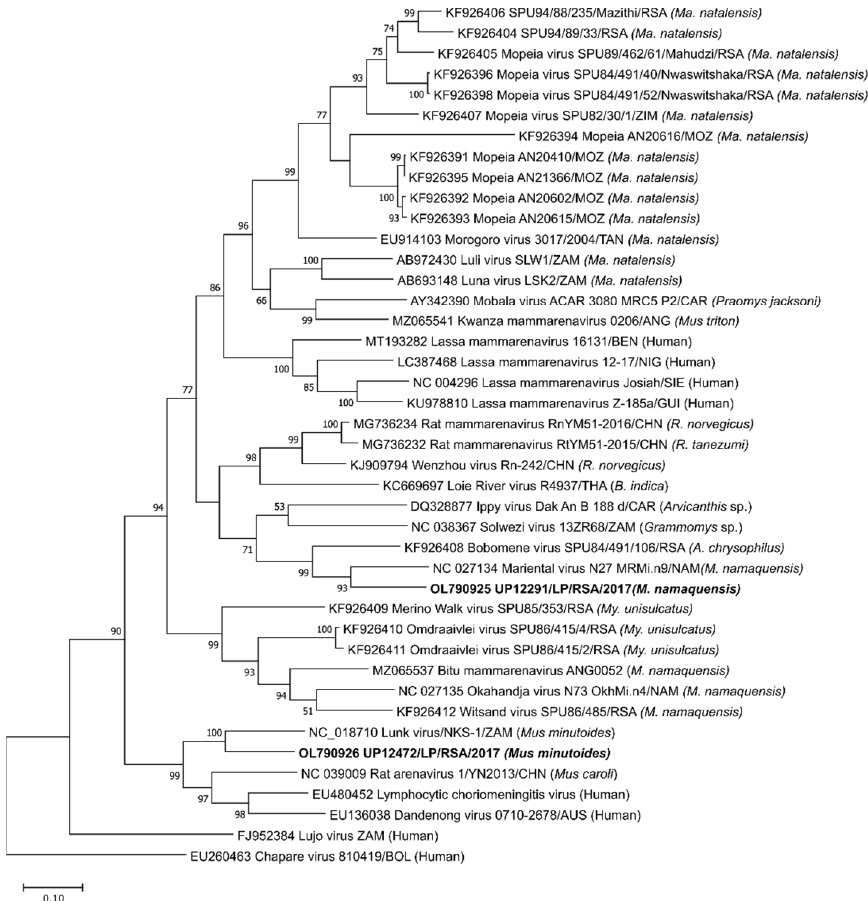
Figure 3. Phylogeny of a 912-nucleotide region of the S segment nucleoprotein gene constructed by maximum likelihood approach using the Jukes-Cantor substitution model in MegaX with 1000 bootstrap replicates. Sequences in bold denote those reported from this study. All host species of origin are indicated, including countries from which viruses were reported as standard 3-letter country codes.